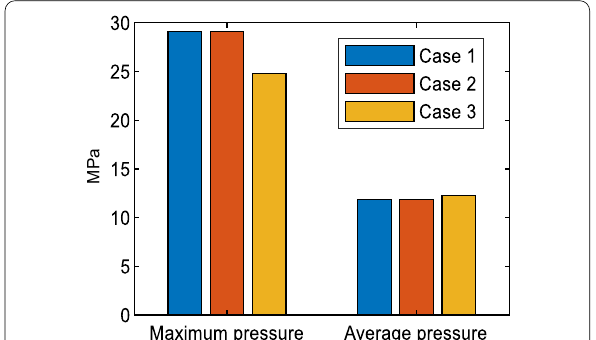
Figure 8 Pressure of hydraulic cylinder for different cases